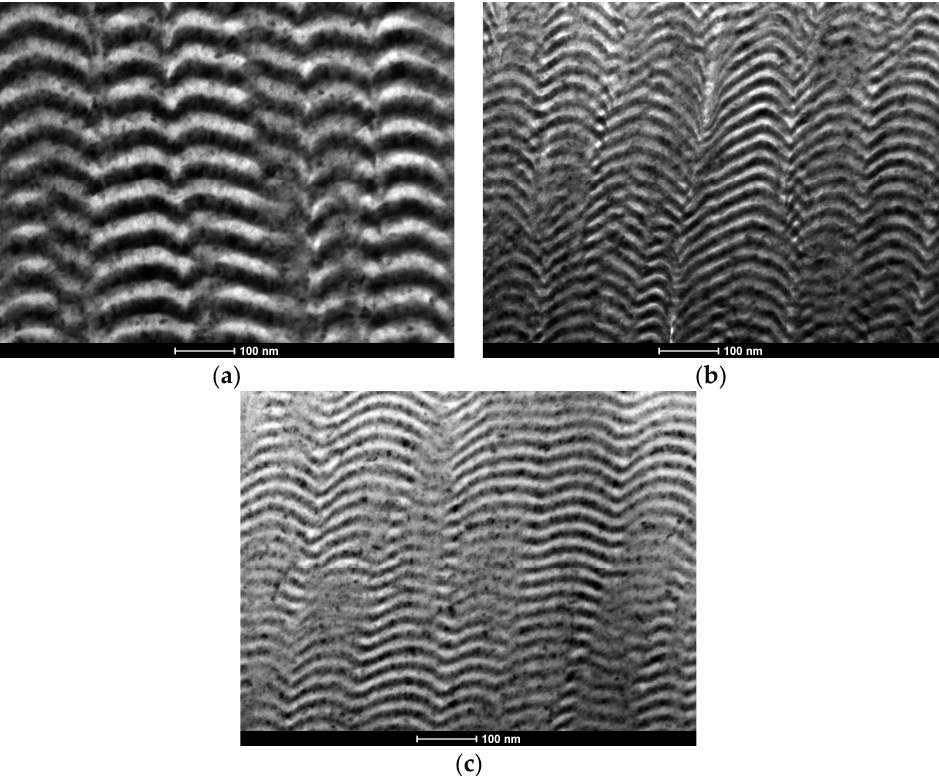
Figure 4. BF TEM cross-section micrographs of Al / Ni (V) films: ( a ) Λ = 50 nm; ( b ) V S = − 80 V; ( c ) ion gun on.